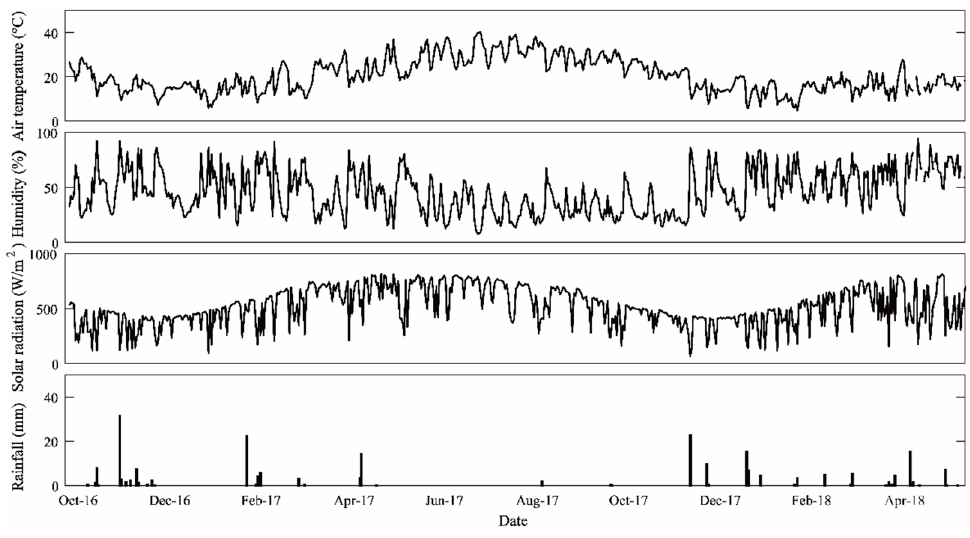
Figure 2. Time series of the main meteorological variables measured at the study site, Morocco.